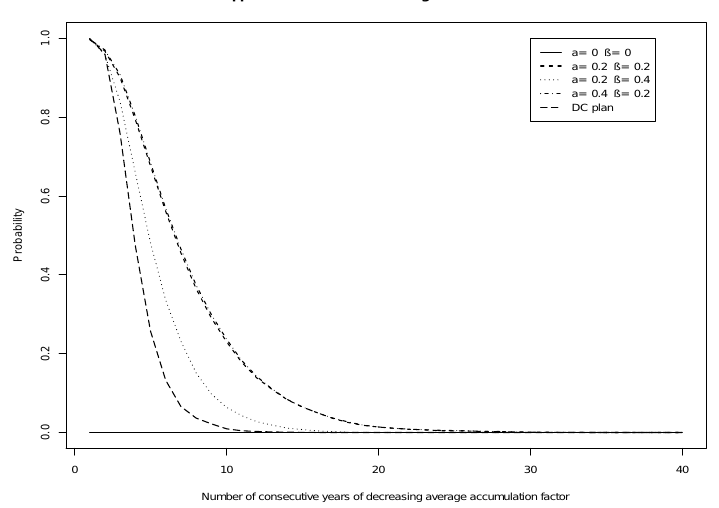
Figure 8. Disappointment for the more realistic membership when the target funding level ¯ F = 120%. The probability of a declining average AAF plotted against the number of consecutive years that the decline occurs over. Both the investment risk adjustment ( a ) and the AAF adjustment ( b ) are